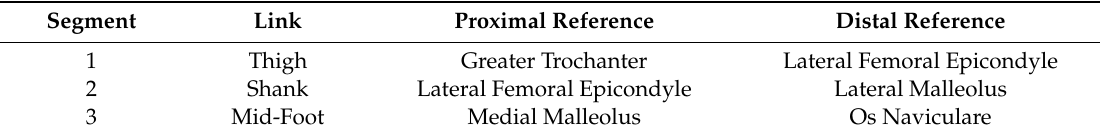
Table 2. References to determine segment lengths.